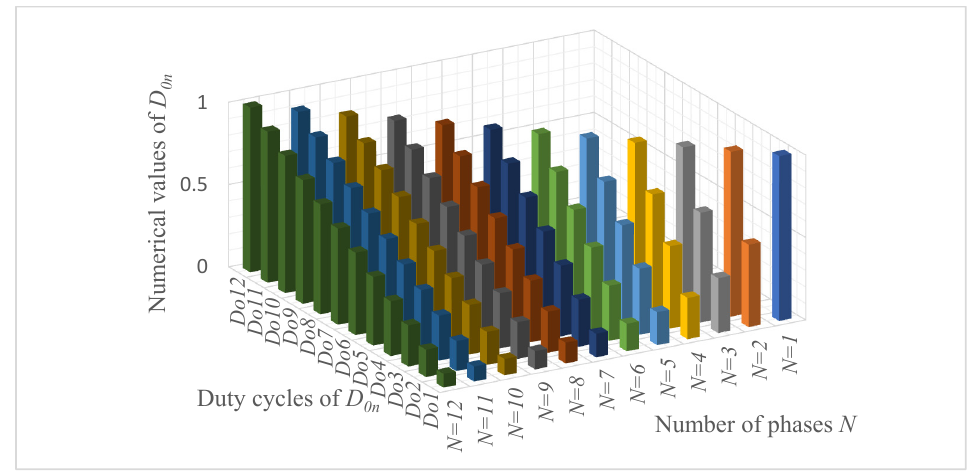
Figure 4. Theoretical duty cycle values with zero-current ripple at different number of phases of interleaved DC–DC converter.